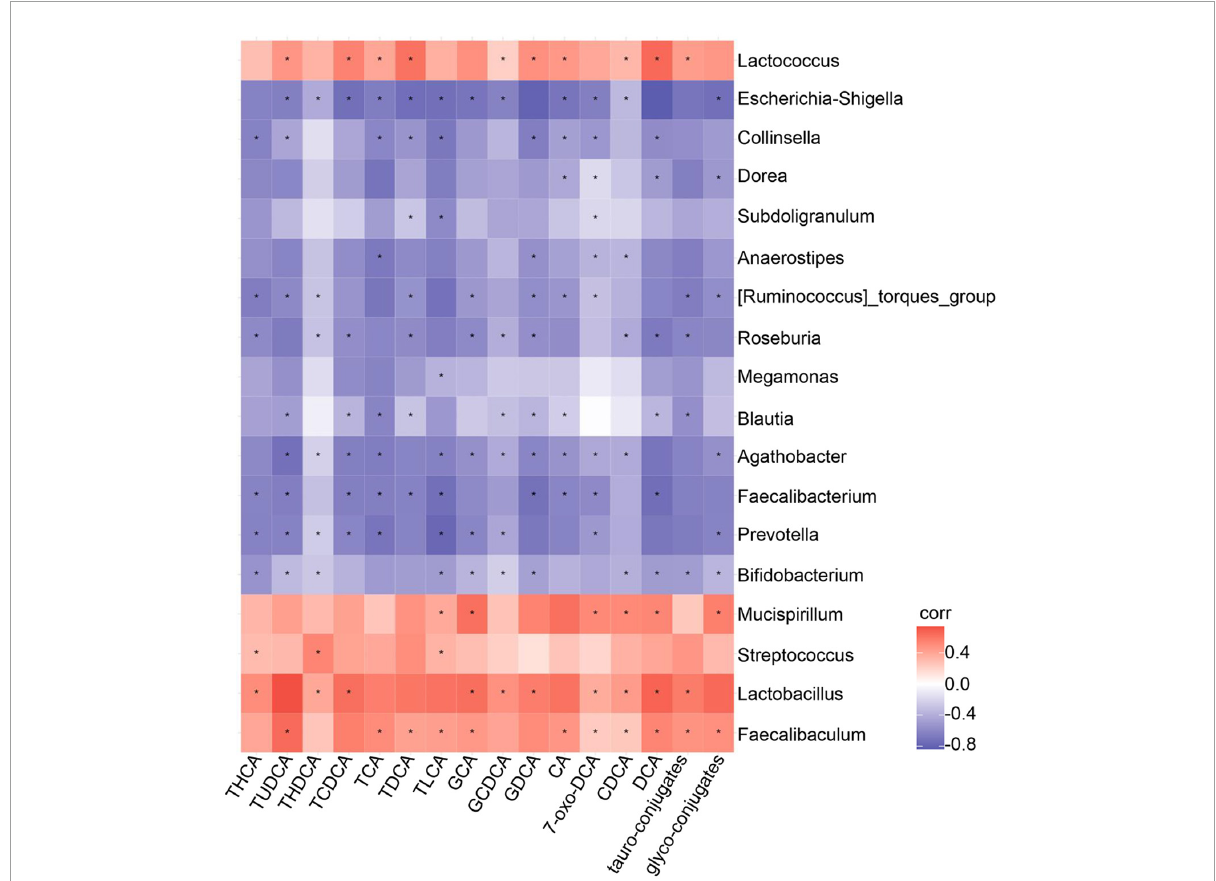
FIGURE6 Assessment of correlation between gut microbiota and serum bile acid profile in HFD-induced mice treated with GEBE: Spearman correlations between the relative abundance of bacterial genera and bile acid profile in the serum ( n = 8). * p <